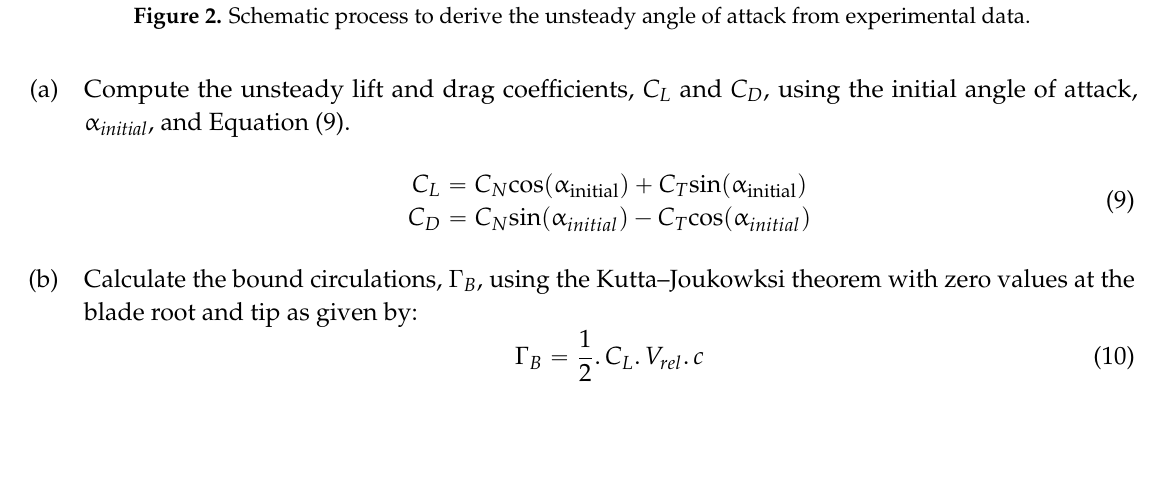
Figure 2. Schematic process to derive the unsteady angle of attack from experimental data.